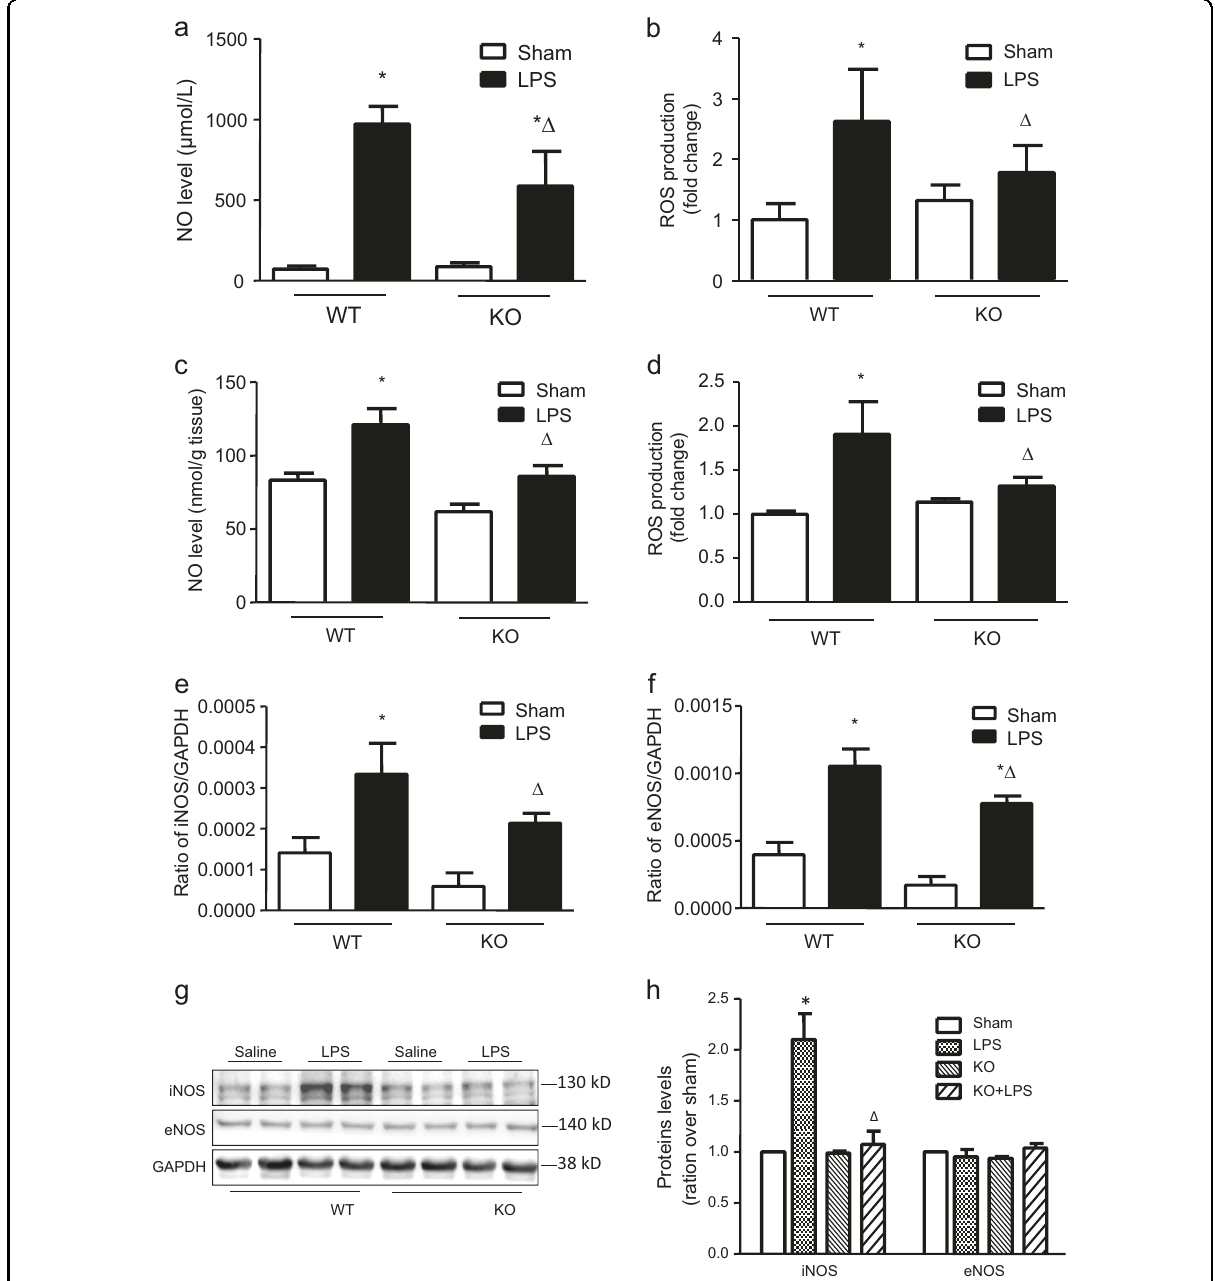
Fig. 4 Changes in NO and ROS concentrations and the iNOS and eNOS mRNA and protein levels in the kidneys of mice with endothelial- speci fi c Capn4 knockout (KO) that were treated with LPS (i.p., 4 mg/kg) for 18 h. NO and ROS concentrations in plasma ( a and b ) and kidney tissue ( c and d ) were measured. Real-time PCR was used to measure iNOS ( e ) and eNOS ( f ) mRNA levels, and western blotting was used to measure iNOS and eNOS protein levels ( g ). h The corresponding bands on the western blot were quanti fi ed via densitometry (protein/GAPDH, presented as fold changes with respect to Sham). * P < 0.05 vs. the WT Sham group; Δ P < 0.05 vs. the WT LPS group, n = 6 –